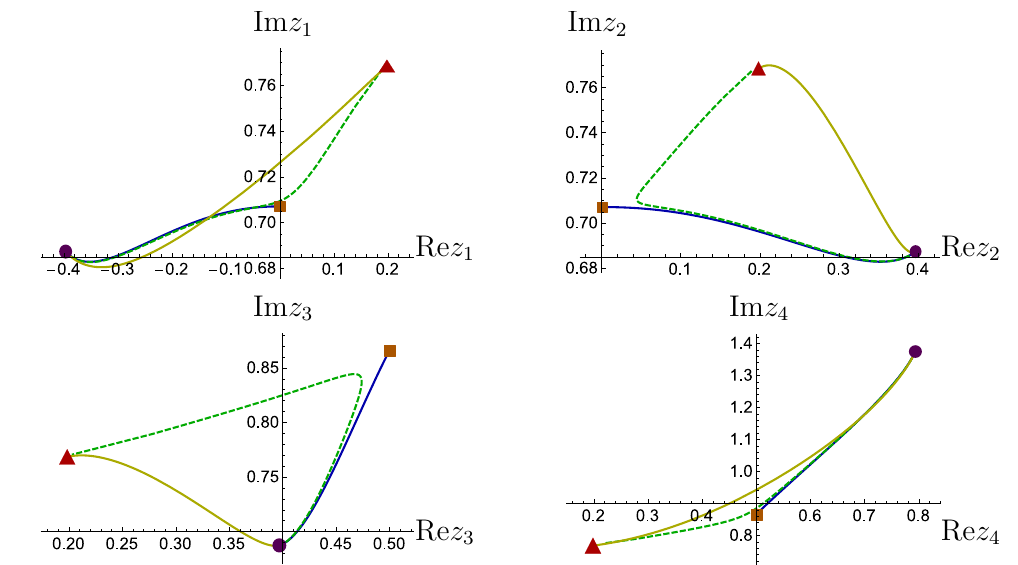
Figure 3 . Numerically integrated domain-walls that interpolate between the G 2 solution (red triangle), the SU(3) U(1) solution (brown square) and the SO(4) solution (purple circle). They (cid:2) form a one-parameter family of domain-walls delimited by two solid lines: the limiting domain-wall dual to the GY (cid:13)ow (blue solid line) and the bounding domain-wall (yellow solid line). In both cases additional scalar identi(cid:12)cations occur which translate into symmetry-enhanced domain-walls. The dashed, green line corresponds to a generic domain-wall with (cid:16) (SO(4)) close to the = 2 SU(3) U(1) (cid:12)xed point without reaching N (cid:2)